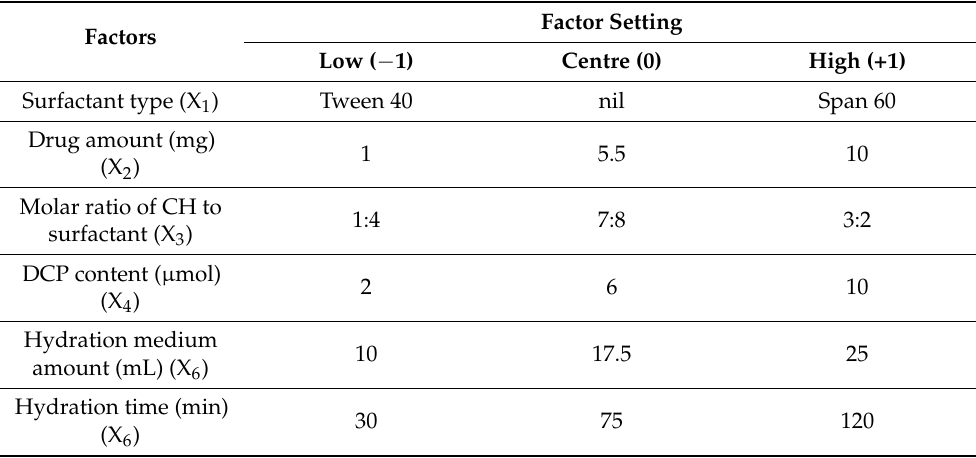
Table 1. 2 (6 − 2) screening design, providing values and coded units with centre points. Factor Setting Factors Low ( − 1) Centre (0) High